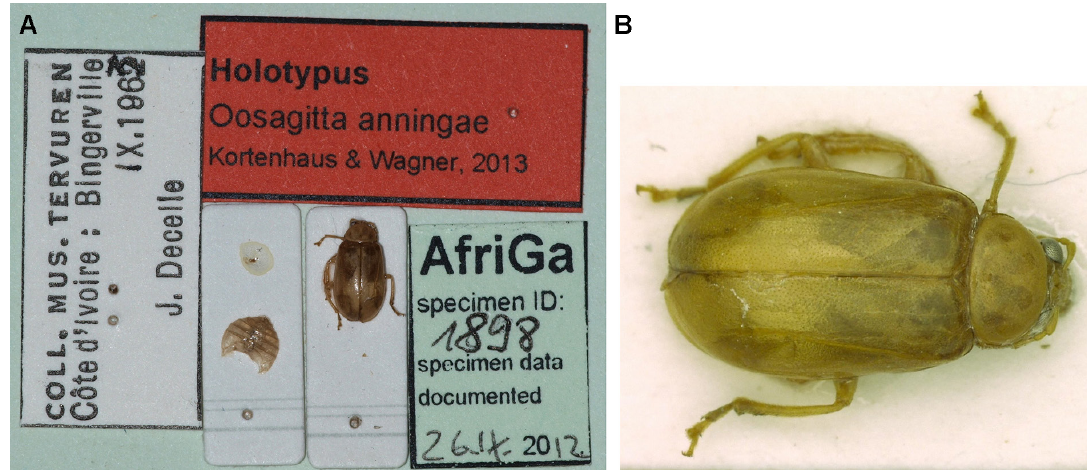
Fig. 18. Holotype of O. anningae sp. nov. A . Overview with labels. B . Close-up of